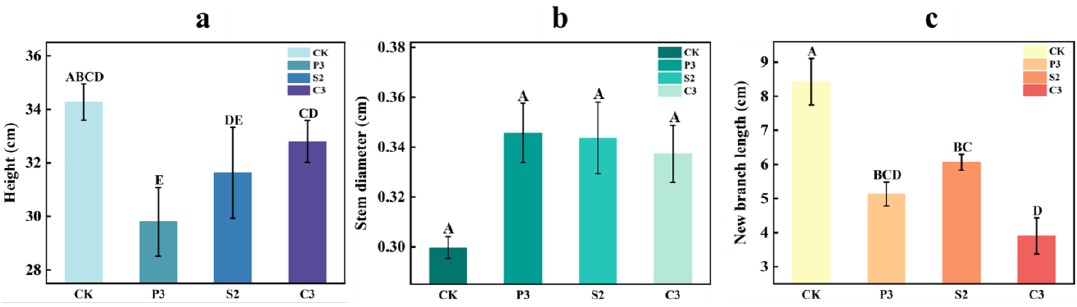
Figure 1. Effects of PGRs on growth characteristics of M. alternifolia. ( a ) Plant height, ( b ) stem diameter, ( c ) new branch length. Note: different letters followed the mean indicate significance at p < 0.01 according to Duncan’s multiple range test.